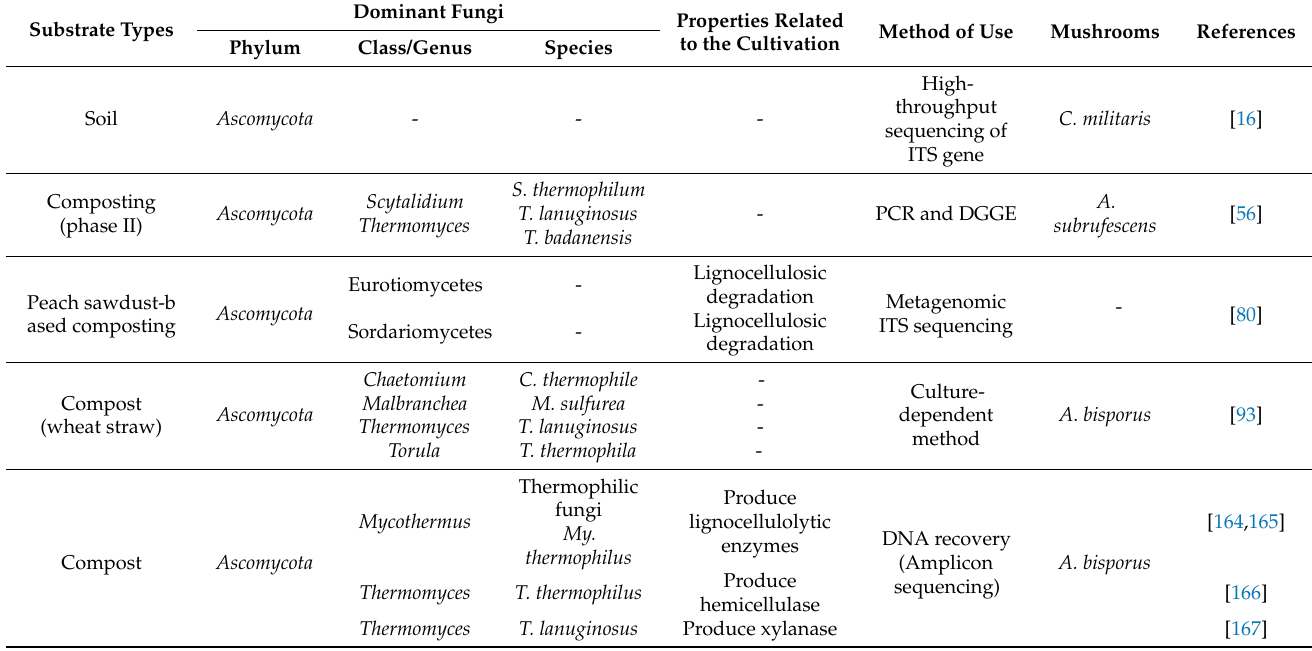
Table 3. Dominant fungal community in different types of